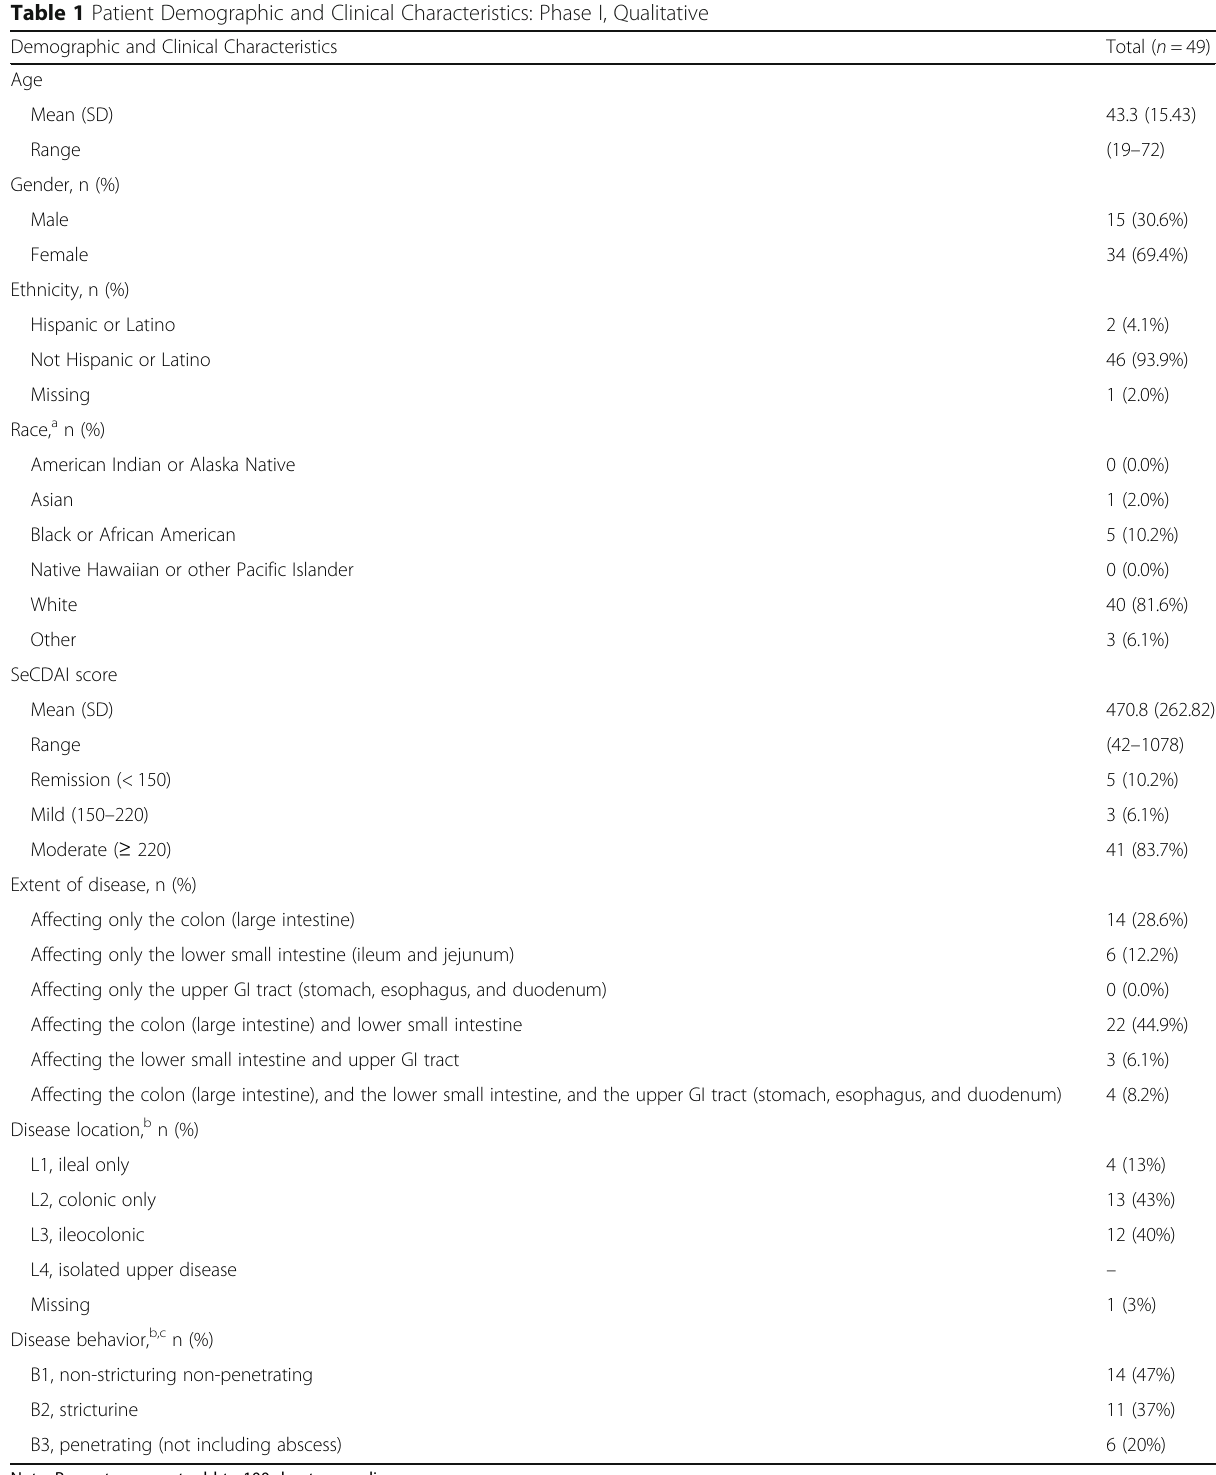
Table 1 Patient Demographic and Clinical Characteristics: Phase I, Qualitative Demographic and Clinical